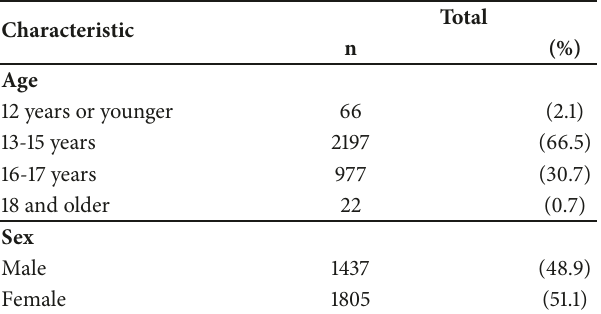
Table 1: Description of study participants of the 2016 Sri Lankan Global School-Based Survey